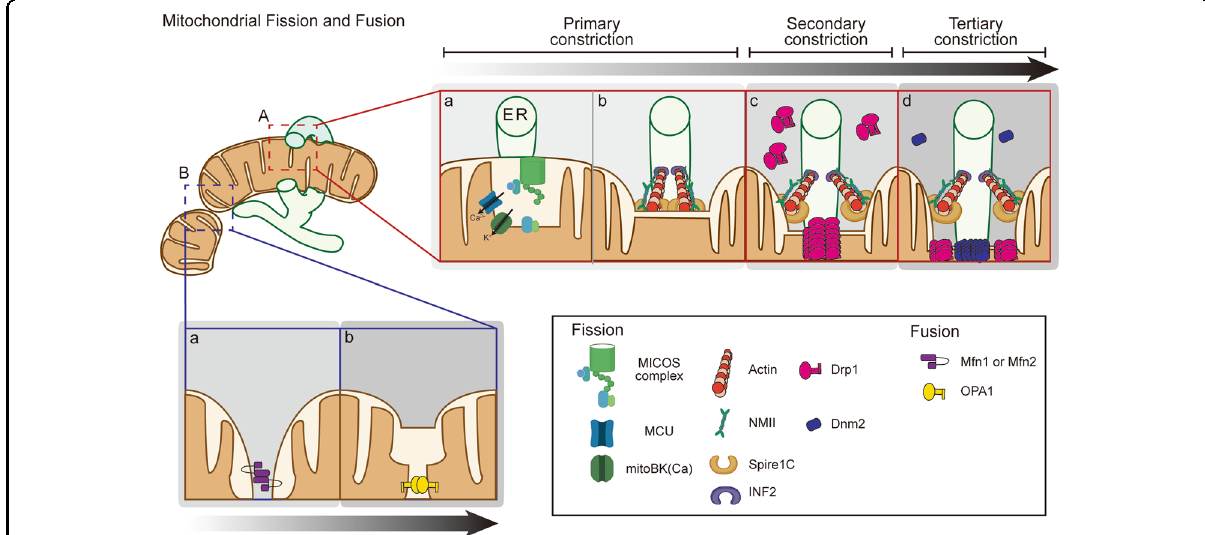
Fig. 1 Mechanism of mitochondrial fi ssion and fusion. a A mitochondrion is divided via multiple constrictions of the OMM and IMM. A The majority of mitochondrial fi ssion takes place at contact sites between the mitochondria and the ER, which act as platforms for the accumulation of various proteins, such as actin, ion channels, and motor proteins, to initiate the constriction of the OMM and/or IMM. INF2 and spire1C induce actin polymerization on the ER side and mitochondrion side, respectively, allowing for the generation of an MNII-mediated pulling force. B IMM constriction proceeds independent of actin polymerization and Drp1 activation. It is required for the MCU-dependent Ca 2 + in fl ux that destabilizes the mitochondrial inner structure. Ca 2 + in fl ux activates mitoBK(Ca), which induces mitochondrial bulging. C Cytosolic Drp1 forms a ring structure at the constricted site, which further constricts the mitochondrion by GTP hydrolysis. D Dnm2 fi nally constricts the mitochondrion to a diameter of <10 nm, which is suf fi cient for lipid autocleavage. b Mitochondrial fusion is mediated by dynamin-related proteins, such as Mfn1/2 and OPA1. When two mitochondria approach each other, Mfn docking is initiated. The interaction between Mfns in their non-GTP binding state reduces the gap between the mitochondria. Then, GTP hydrolysis drives membrane fusion. Because OPA1 interacts with Mfns, it may promote IMM fusion following OMM fusion. Oligomerization and GTP hydrolysis promote conformational changes that bring the two membranes into close proximity, facilitating IMM